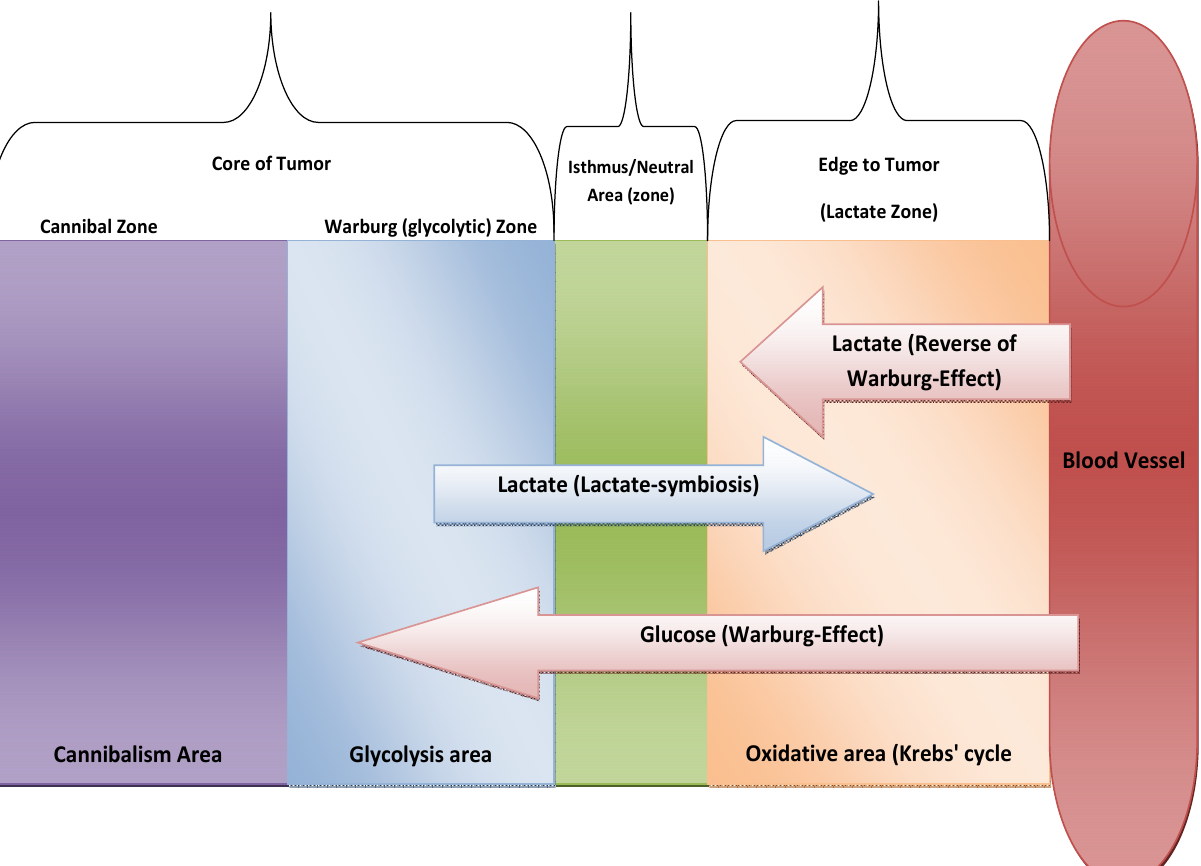
Figure 5. Tumor as integrated metabolic ecosystem, this model represents cancer colony as multi-layers including isthmus and/or neutral area that prevent transgress between Glycolytic phenotypic of cells and metabolic types of cells. This model is so compatible with a recent model that supported experimentally in brain tumor [54]. Because tumor cell at edge rely on lactate as energetic fuel, we suggest the term it as o “Lactate zone”. We suggest to term “ multi-layers ” and/or “ multi-zones ” to describe that tumor colony consists of several zones; each zone has distinguished energetic fuel differs from others but at the end most of these zones are in symbiotic (mutual) relationship [Cannibal zone, Warburg (glycolytic)zone, isthmus zone and Lactate